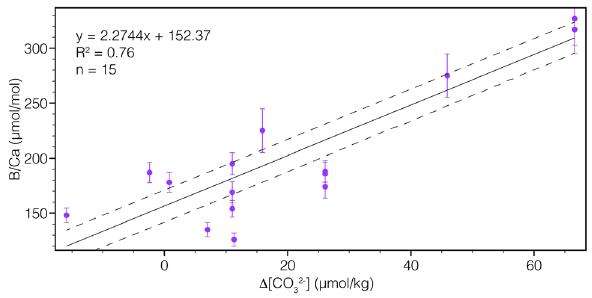
Figure 7. Calibration of core-top B/Ca (1σ-error bars) against pre-industrial water mass Δ[CO 32− ] 6 .